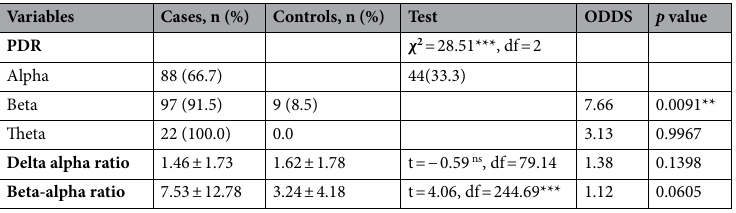
Table 1. Qualitative and quantitative EEG parameters. Descriptive statistics n (%), means, chi-square test (x 2 ,